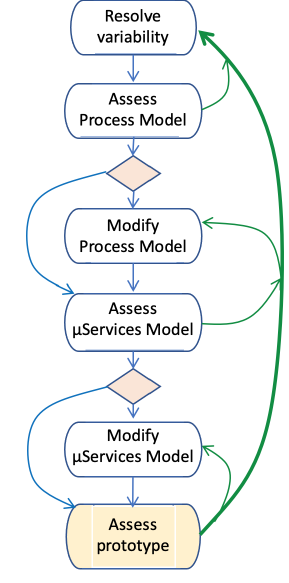
Figure 4. The low-code development